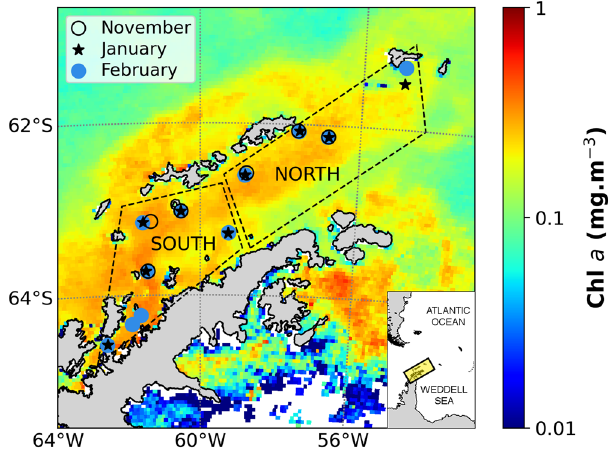
Fig. 1 Study area. Location of hydrographic stations is marked by open circles (November), stars (January), and blue circles (February). The black dashed lines indicate the subregions (north and south) along the NAP and delimit the areas used to estimate average remote sensing measurements. The decadal-mean (2010 – 2019) remote sensing chlorophyll- a (Chl- a ) is exhibited in the background, indicating the biomass (Chl- a ) distribution of phytoplankton along the NAP in the last decade. An inset map in the lower right corner shows the location of the NAP within the Atlantic sector of the Southern